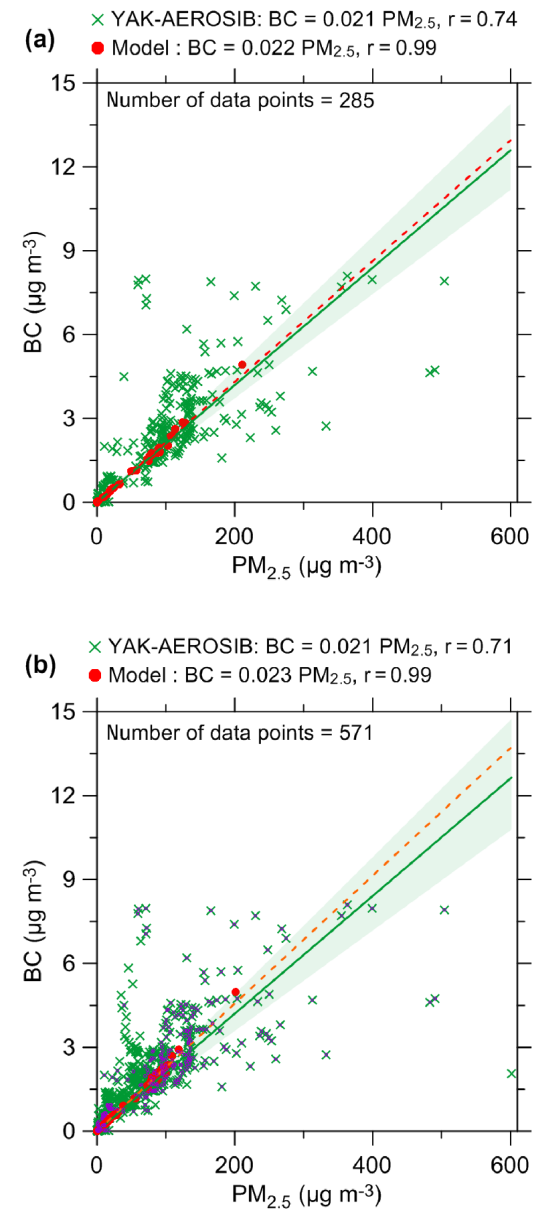
Figure 10. Relationships between BB BC and PM 2 . 5 concentra- tions obtained from the YAK-AEROSIB observations and from the simulations performed with the optimized BC and OC emissions. The relationships were obtained by selecting PM 2 . 5 and BC con- centrations matching (in space and time) the measured CO mixing ratios that exceed the 90th percentile (a) or 80th percentile (b) of the observed distribution of the CO mixing ratios. Purple dots depicted in (b) represent the observational data shown in (a) . The figure leg- ends give the equations for a simple linear regression without an intercept. The shaded areas indicate the 90th percentile confidence intervals for the linear regression lines fitted to the measurement